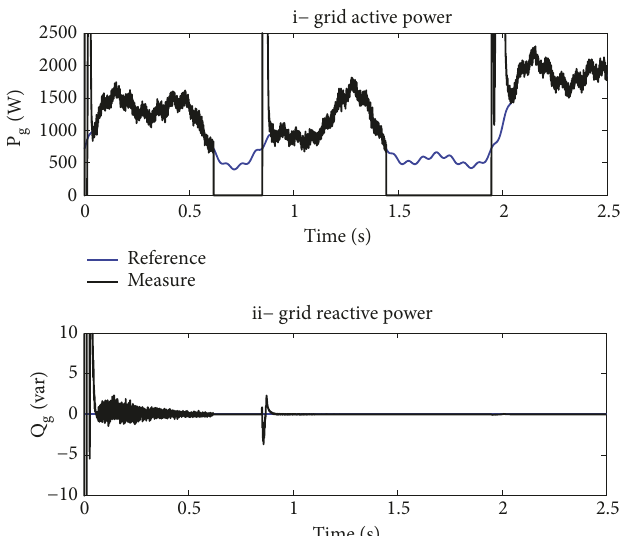
Figure 13: Active and reactive grid power in automatic switching mode.